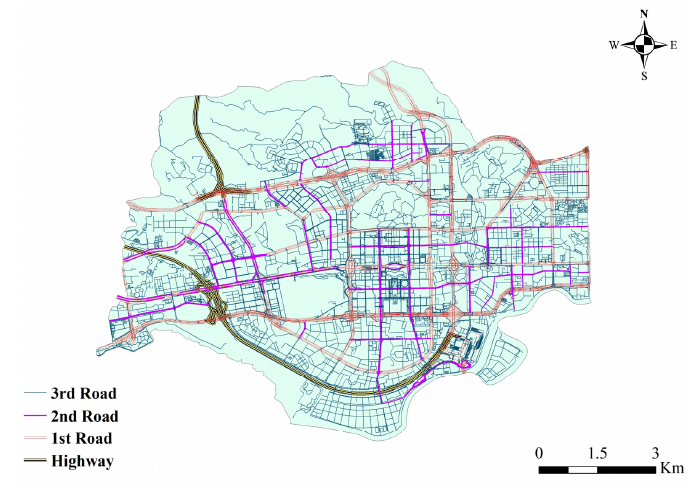
Table 6. Statistics of roads at all levels in Futian District, Shenzhen.